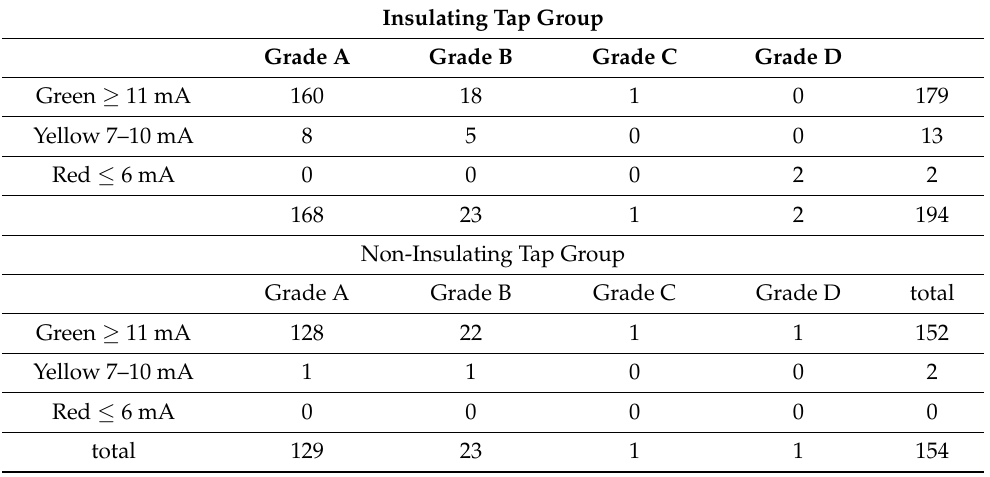
Figure 3. This is a case of L3-4 lumbar lateral interbody fusion and percutaneous pedicle screw for lumbar spinal stenosis. Left L4 monitor indicated 8 mA. Postoperative CT scan showed lateral perforation of the left L4 pedicle on the tapping and pedicle fracture. Table 2. The result of TrEMG and postoperative computed